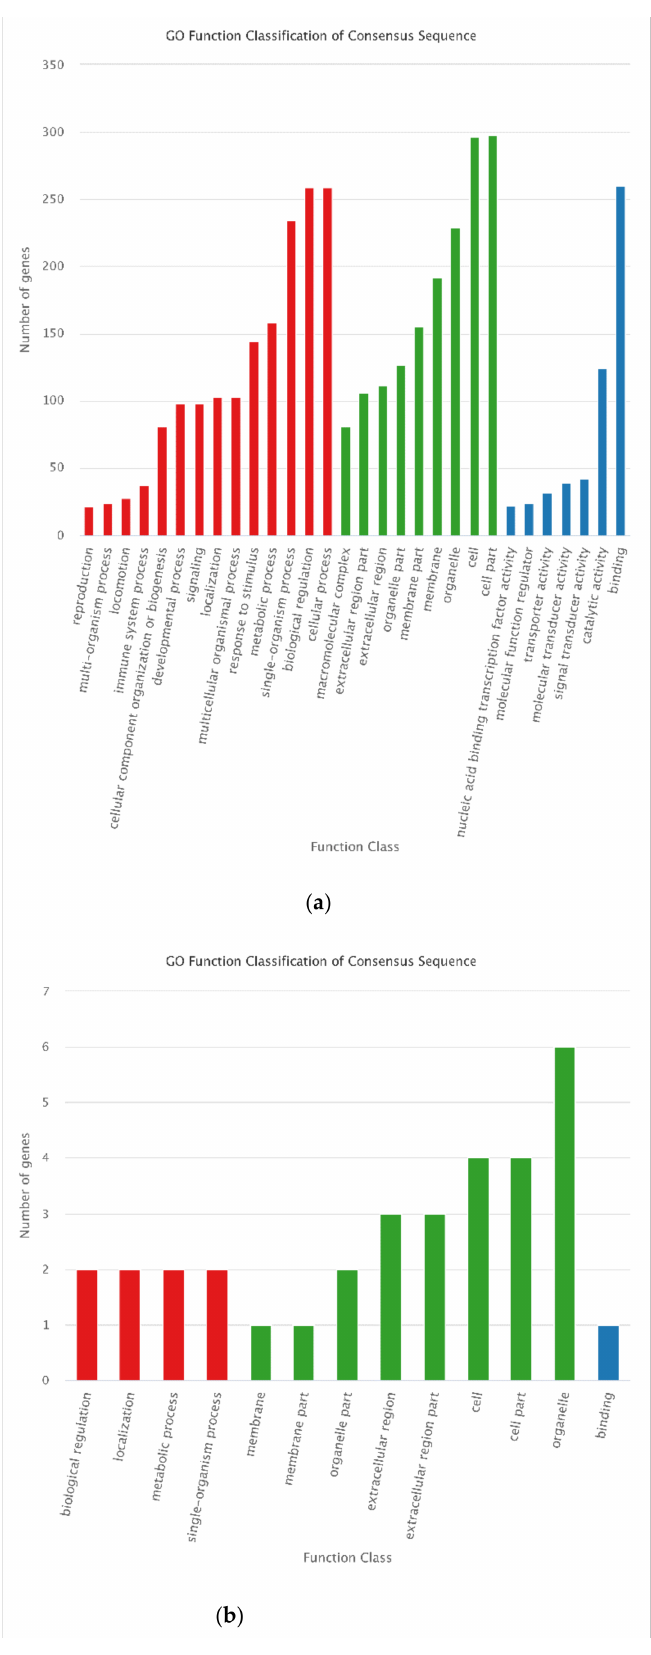
Figure 11. GO classification of the 488 DEGs and 16 DEPs. For GO annotation, the abscissa is the GO term, and the ordinate indicates the number of DEGs annotated to GO terms. ( a ) GO classification of the 488 DEGs. ( b ) GO classification of the 16 se-lected